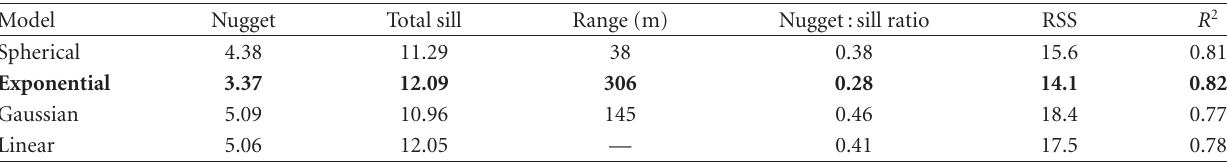
Table 7: Fitted semivariogram models nugget, total sill, range, nugget to sill ratio, residual sum of square (RSS), and R 2 value of EC 1:1 at 0–20cm depth during 2009 (best fitted model is in bold).